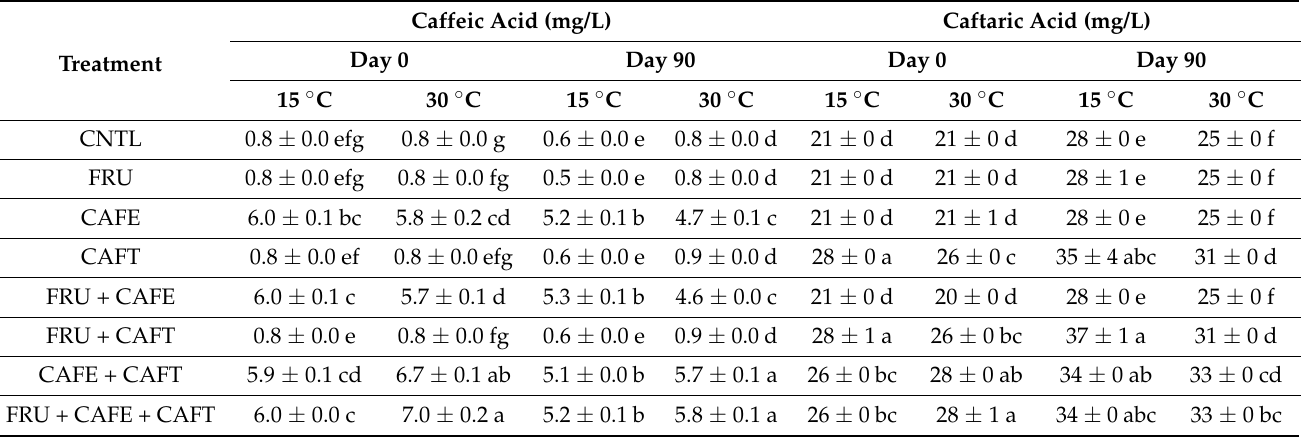
Table 1. Caffeic and caftaric acid concentrations determined via Liquid Chromatography-UV Diode Array Detection (LC-UV/DAD) after treatment additions to base wines at the start (Day 0) and end (Day 90) of the temperature-controlled storage